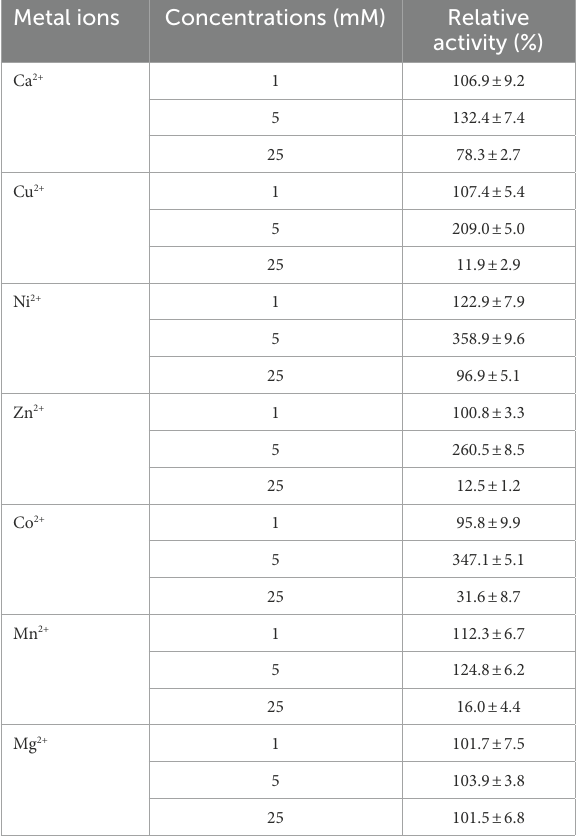
TABLE 2 The effects of several different concentrations of metal ions on the activity of recombinant Lip54q. Metal